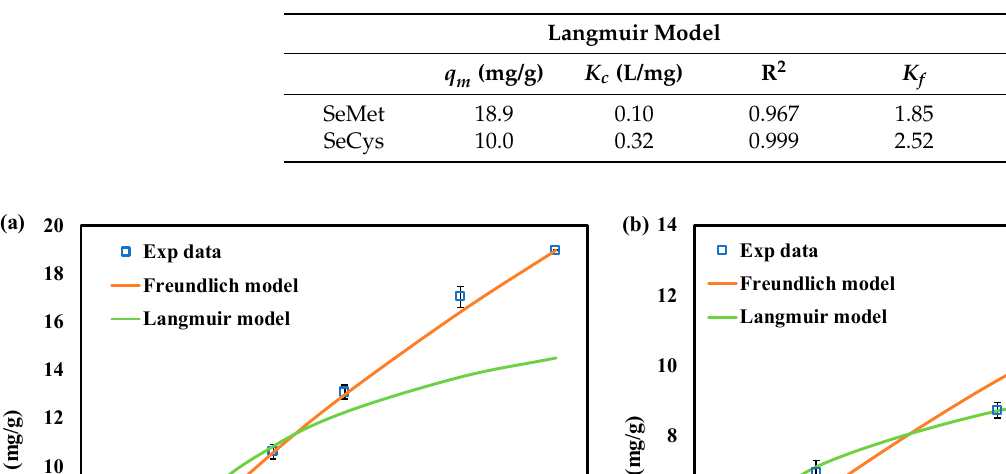
Table 3. Adsorption isotherm parameters for organoselenium by GAC.